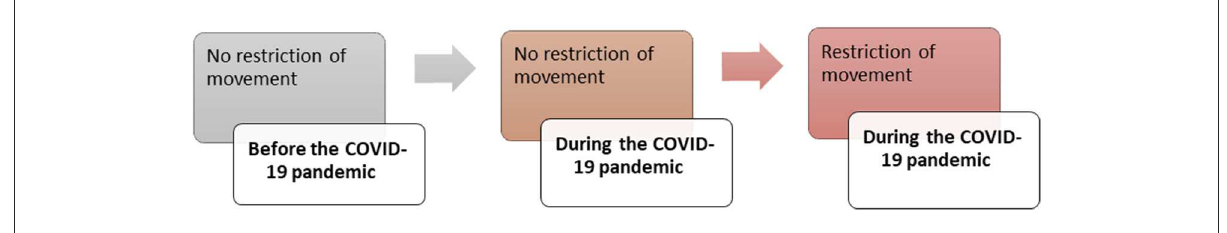
FIGURE1 Physical activity before and during the COVID-19 pandemic. Movement restriction in the included studies was due to lockdown, home confinement, community quarantine, or physical distancing policies combined with school closure.